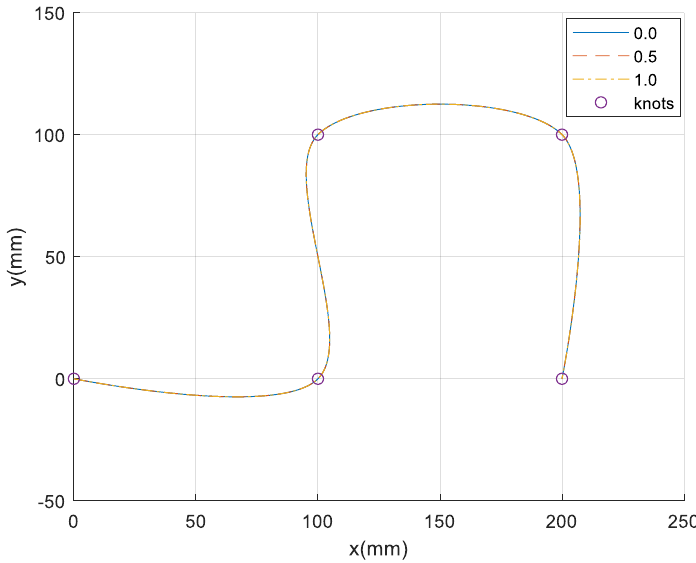
Figure 6. Path for five knots according to β in the task #1.